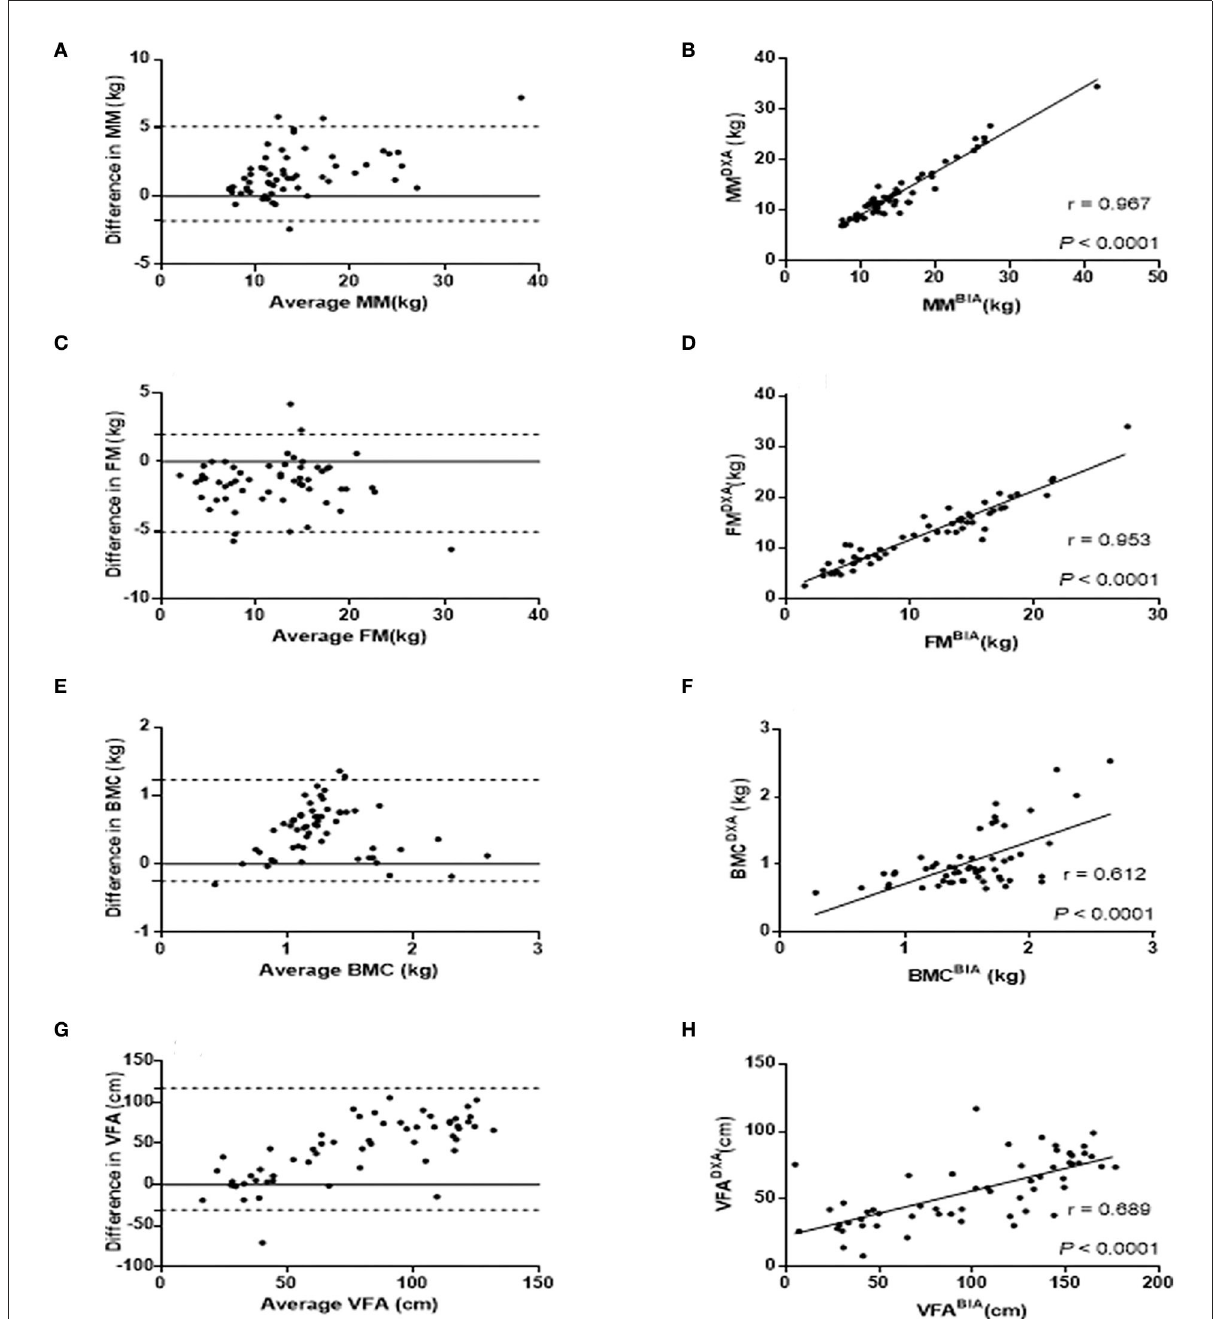
FIGURE2 Comparison of MM, FM, BMC, and VFA measurements by DXA and BIA. Bland-Altman plots were constructed with the difference of MM (A) , FM (C) , BMC (E) , and VFA (G) between DXA and BIA. The differences between the two methods are plotted based on their mean values. The dashed line represents the 1.96 SD value of the two methods. Correlation analysis were applied to identify the correlation of MM (B) , FM (D) , BMC (F) , and VFA (H) between DXA and BIA with correlation coefficient r shown in the scatter plots. FM, Fat mass; MM, Muscle mass; BMC, Bone mineral content; VFA, Visceral fat